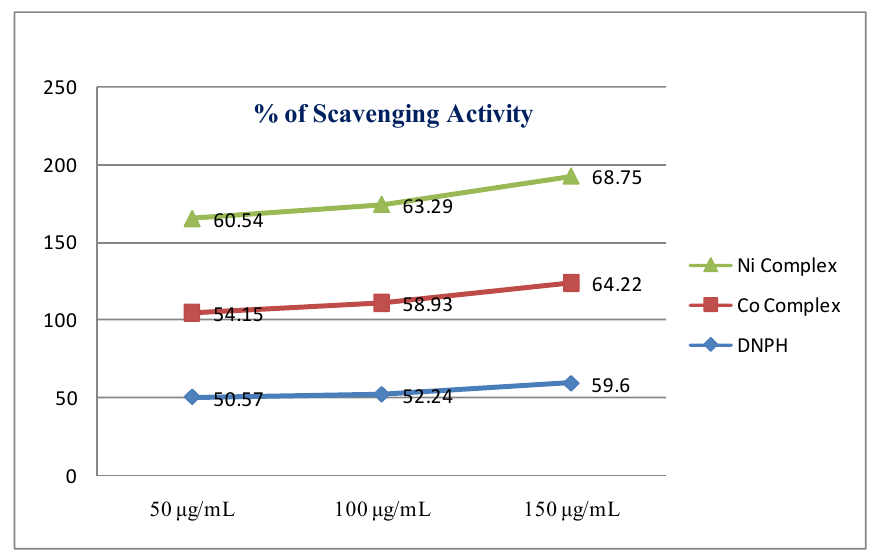
Table 5. Percent of radical scavenging abilities of the Co(II) and Ni(II) complexes and DNPH.